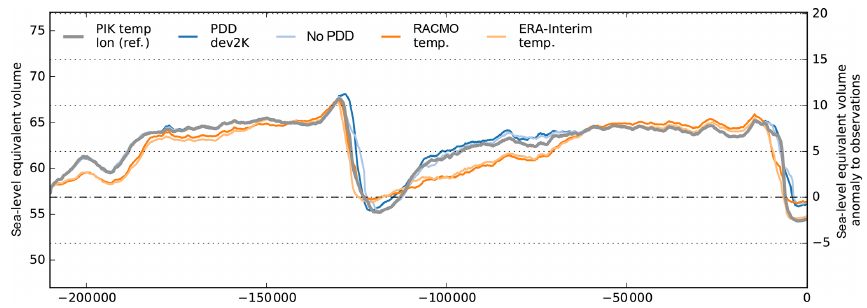
Figure 10. Ice volume above flotation for variation in PDD standard deviation and for different modern mean temperature distributions. The sensitivity is low for different PDD parameters of 5K (reference in grey) and 2K and when no surface model with yearly cycle is used (blue and light blue respectively), also for interglacials. For more realistic annual mean surface temperatures from RACMO2.3p2 (van Wessem et al., 2018) or ERA-Interim (Dee et al., 2011), but without PDD and yearly cycle applied, the simulated volumes show most difference for glacial ice sheet growth and at interglacials (orange and light orange,